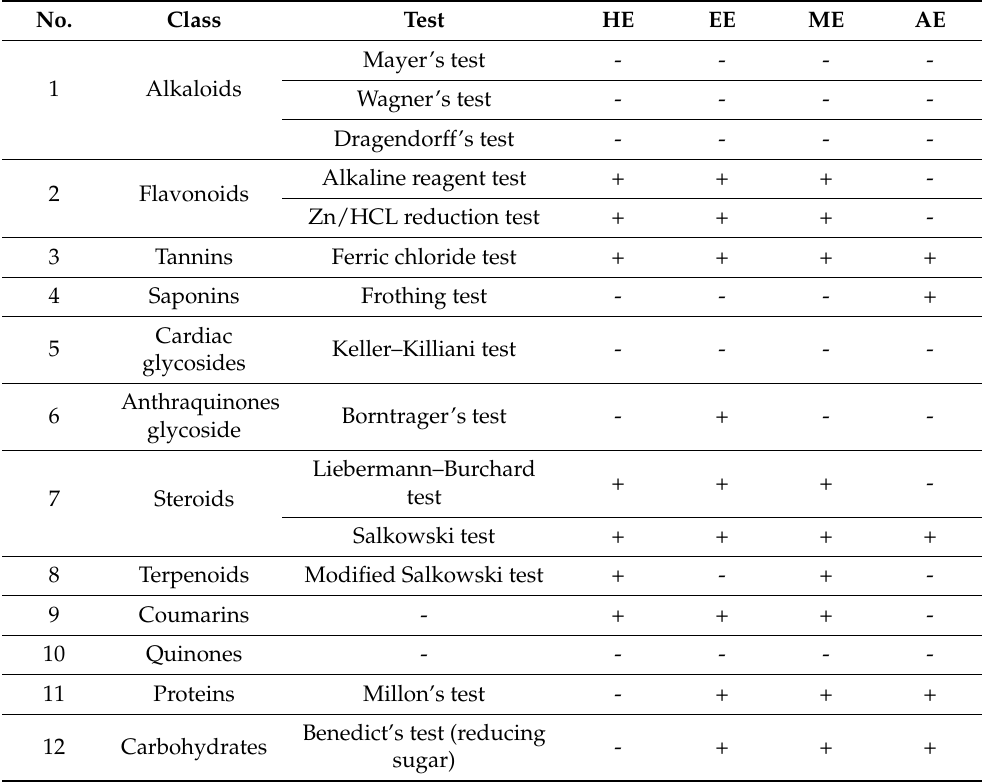
Table 1. Screening of phytochemical content of four different extracts of Cassia timoriensis flower.